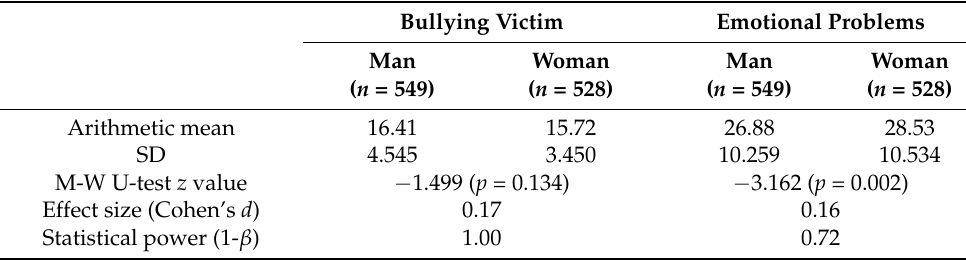
Table 6. Comparison of means according to gender.